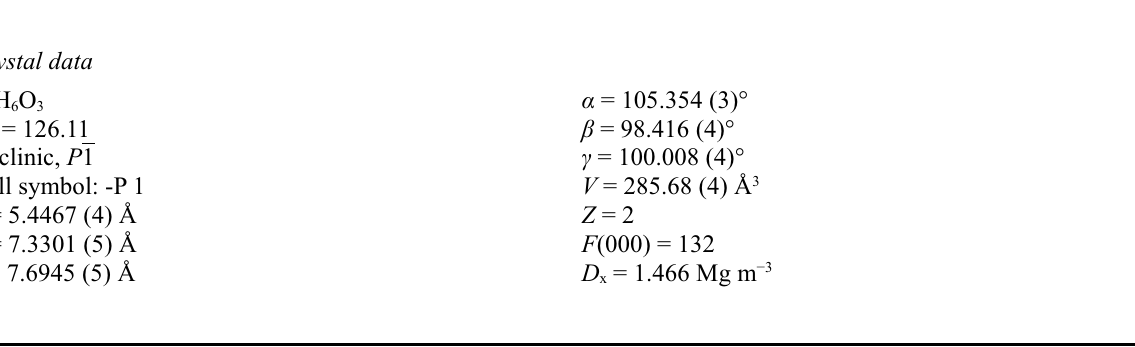
The packing figure ( PLATON : Spek, 2003) which shows that the title compound is dimersed and dimers are connected through H-bonds in helical